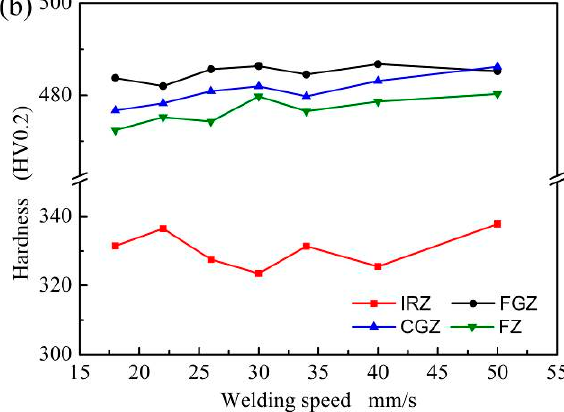
Figure 12. Effect of welding speed on the hardness of weld joint ( a ) hardness of weld joint before and after quenching; ( b ) relationship between the average hardness of different regions of welded joints without quenching and welding speeds.